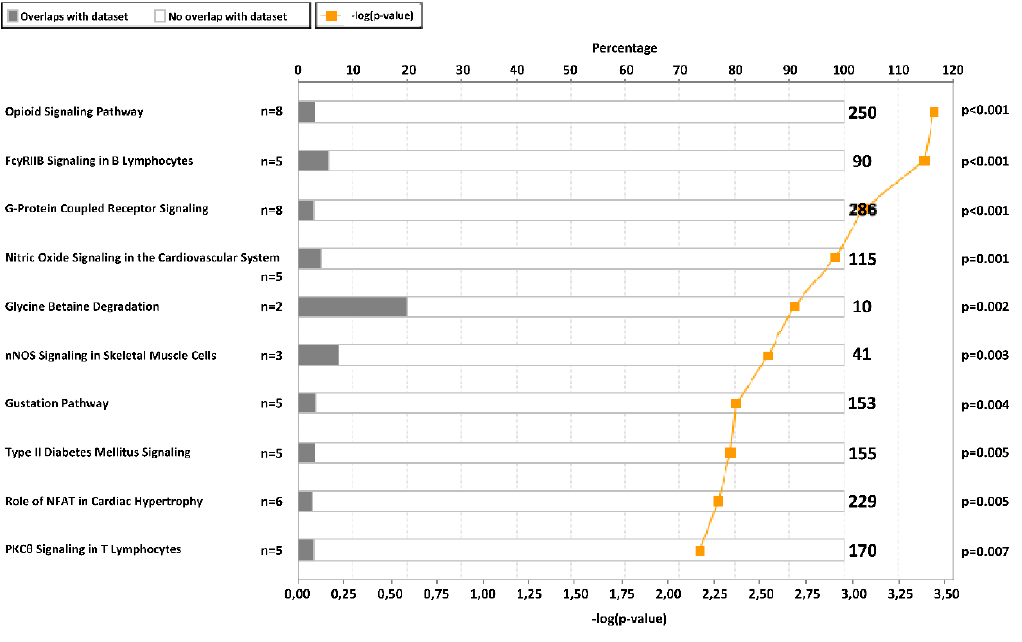
Figure 2. Top 10 canonical pathways from ingenuity pathway analysis of 253 CpGs selected by Spearman false discovery rate (FDR) < 0.05. The graph presents the canonical pathways ordered by − log( p -value) and the percentage of genes from our list that are in one specific pathway (total number of genes in the pathway at the right part of the graph). The p -value adjusted by Fisher’s test is also indicated at the right side.